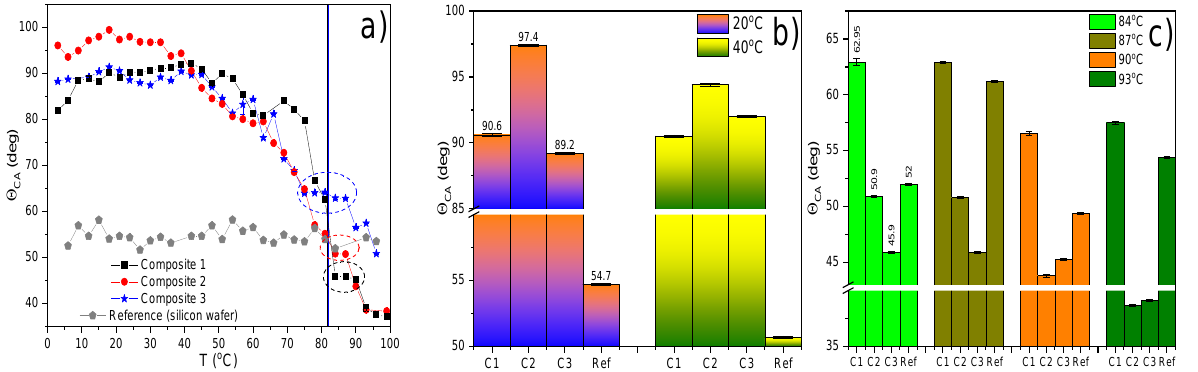
Figure 10. Temperature dependence of the contact angle for Composites 1–3 (C1, C2, and C3), and silicon wafer (Ref) during heating from 0 °C up to 100 °C ( a ). The dashed ellipses outline the step related to the Cr–SmC* A phase transition. Bar chart of contact angle in the crystal phase for two chosen temperatures ( b ) and in the SmC* A phase for the four chosen temperatures ( c ). Error bar is a sum of systematic uncertainty and standard deviation for left and right drop contact angles.